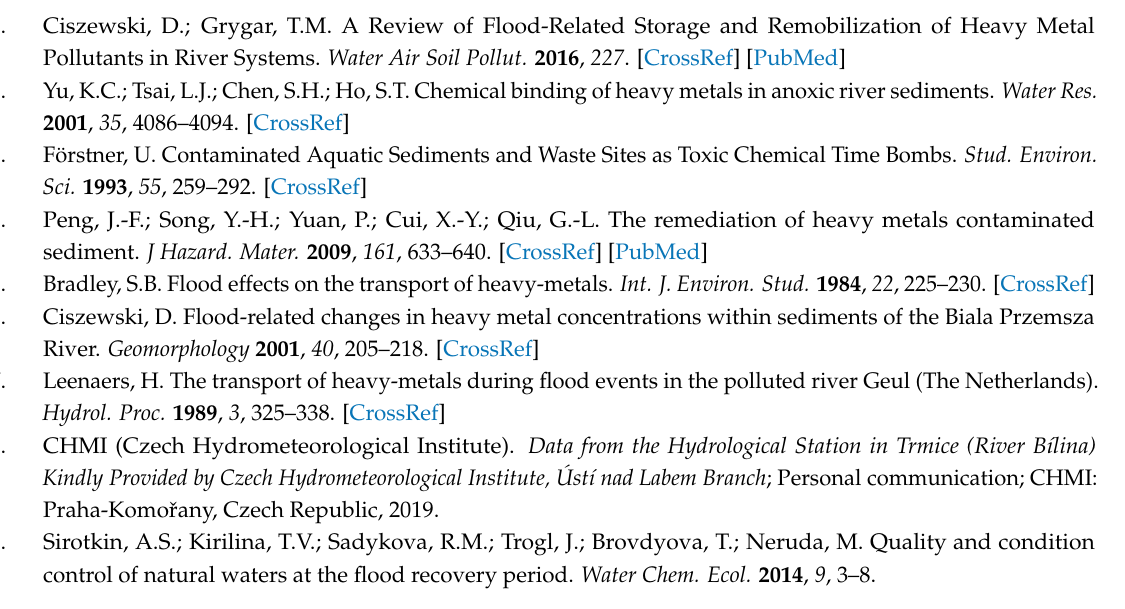
Table S1: Heavy metal content in sediment samples, in mg/kg, before the flood, 2012 [11], Table S2: Heavy metal content in sediment samples, in mg/kg, during the 2013 flood [9], Table S3: Heavy metal content in sediment samples, in mg/kg, after the flood, 2014, Table S4: Heavy metal content in sediment samples, in mg/kg, after the flood,